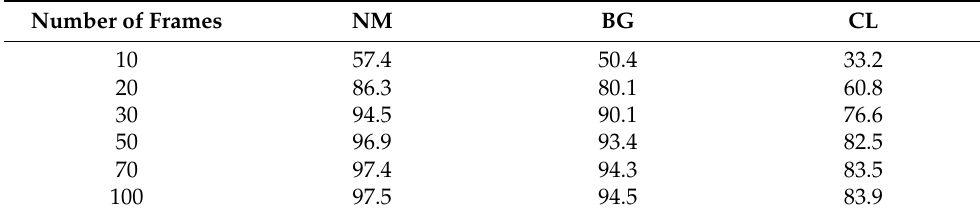
Table 8. The result when the number of input frames is different. Results are rank-1 accuracies (%) averaged on all 11 views, excluding identical-view cases.